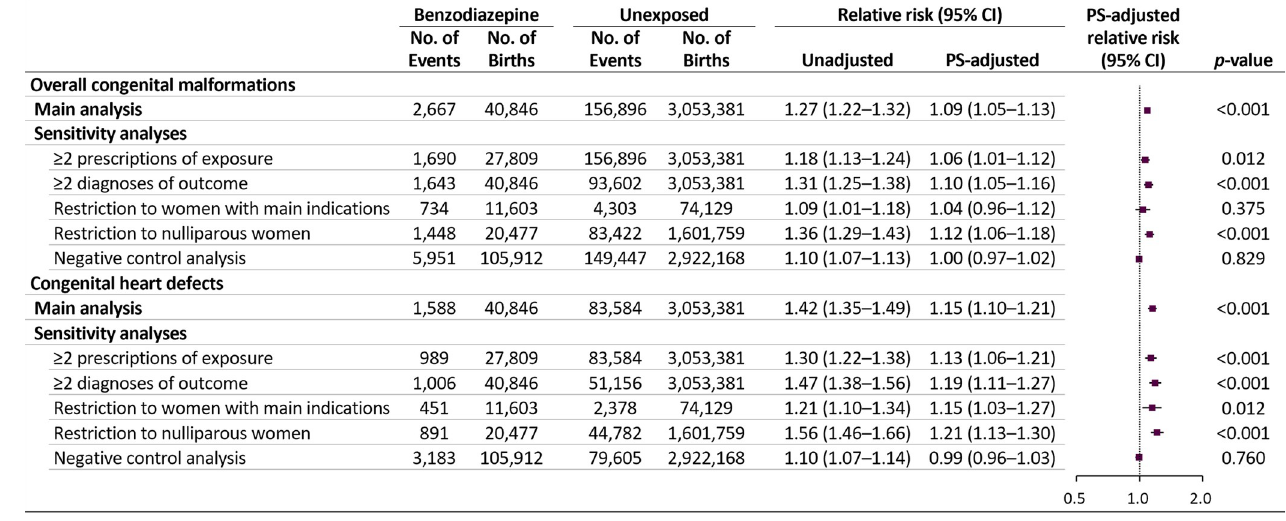
Fig 5. Risks of congenital malformations in infants following maternal exposure to benzodiazepines in the first trimester: sensitivity analyses. CI, confidence interval; PS, propensity score.